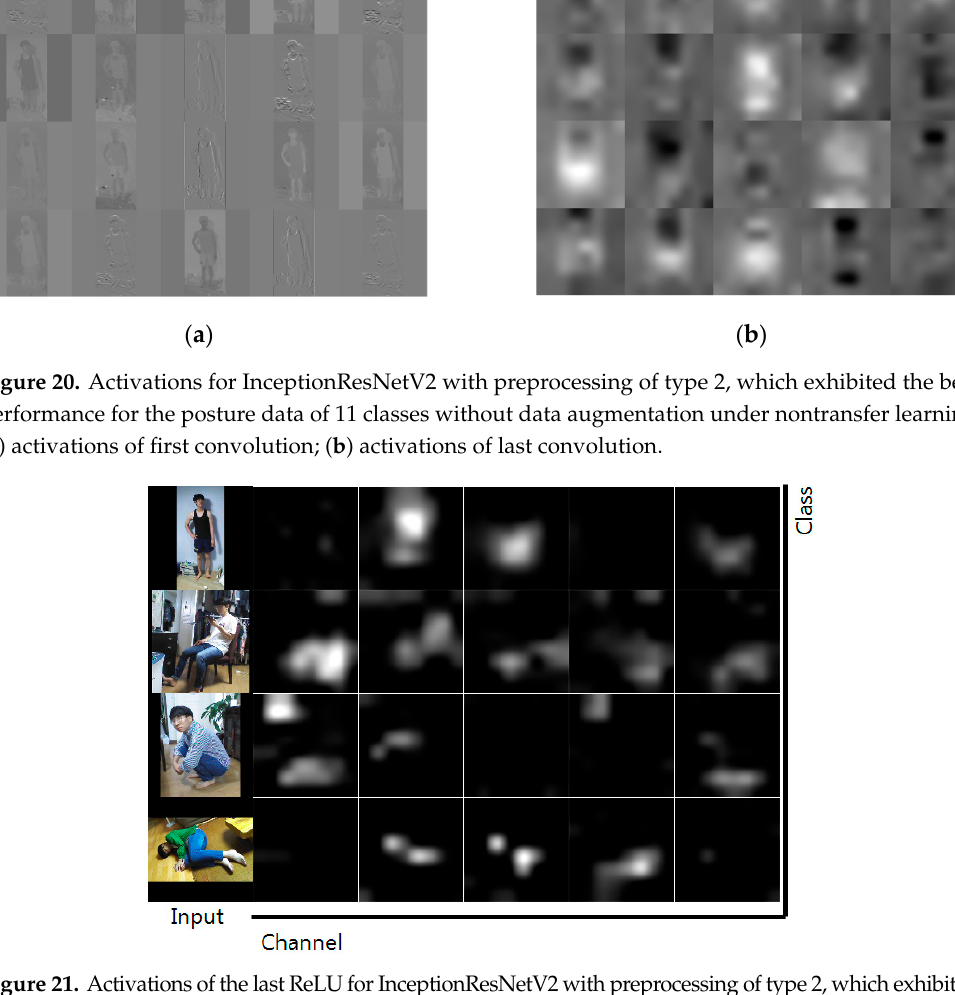
Figure 21. Activations of the last ReLU for InceptionResNetV2 with preprocessing of type 2, which exhibited